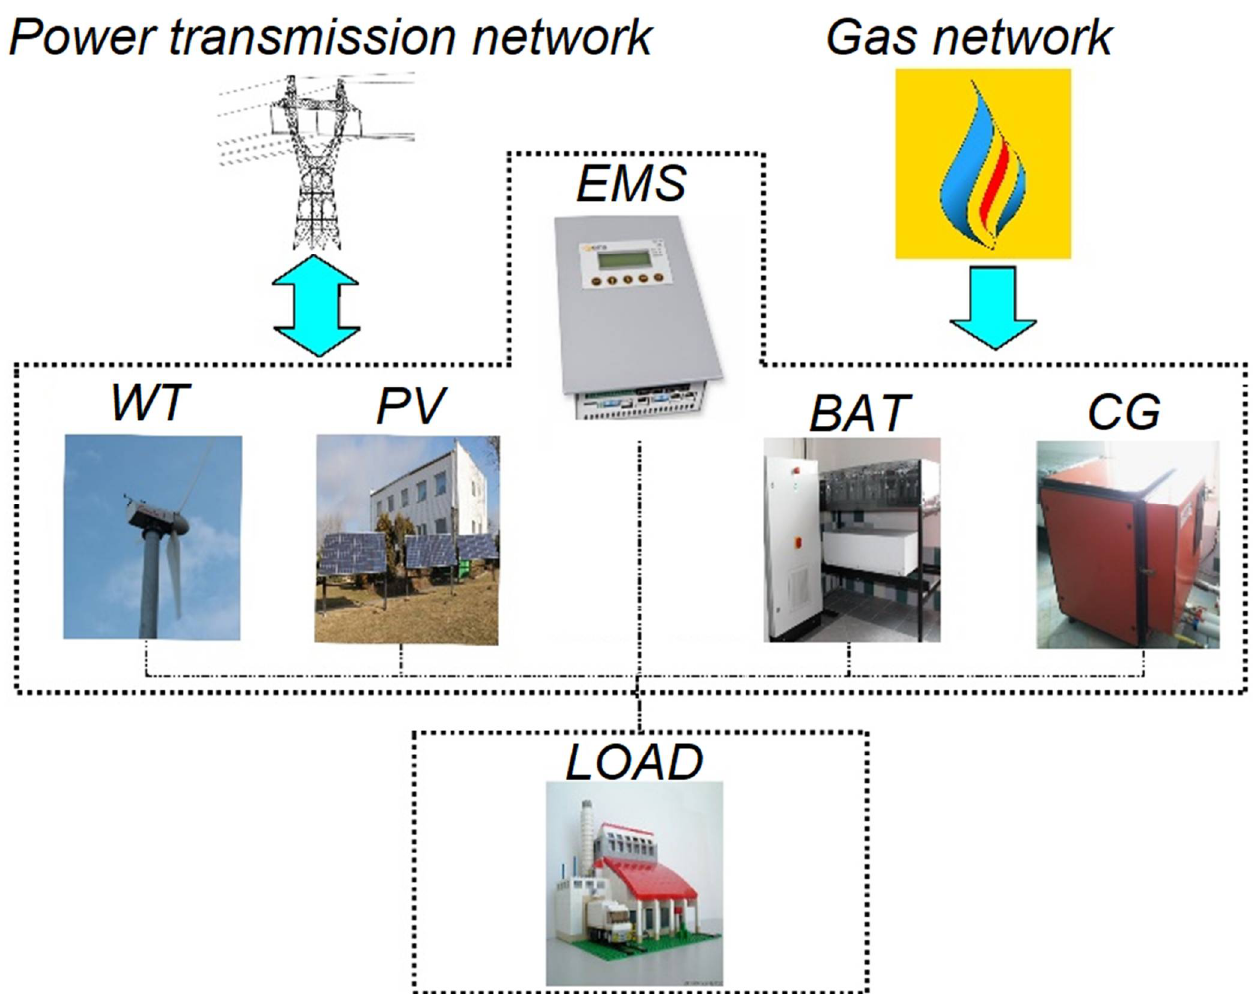
Figure 1. Scheme of the microgrid control system.